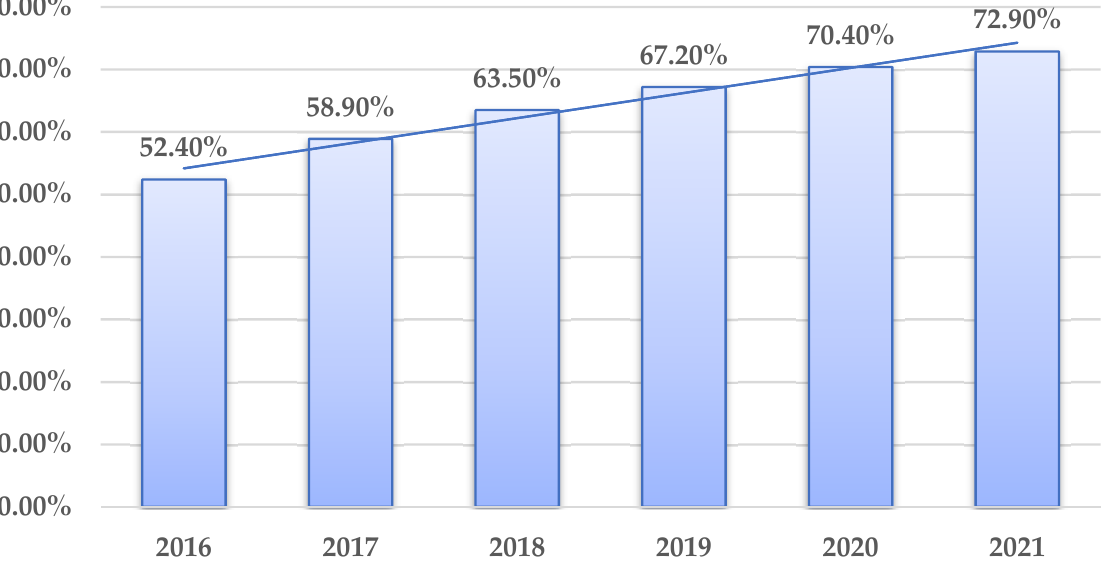
Figure 1. Worldwide m-commerce evolution (% of e-commerce). Source: Own processing based on Statista Databases (Statista a).